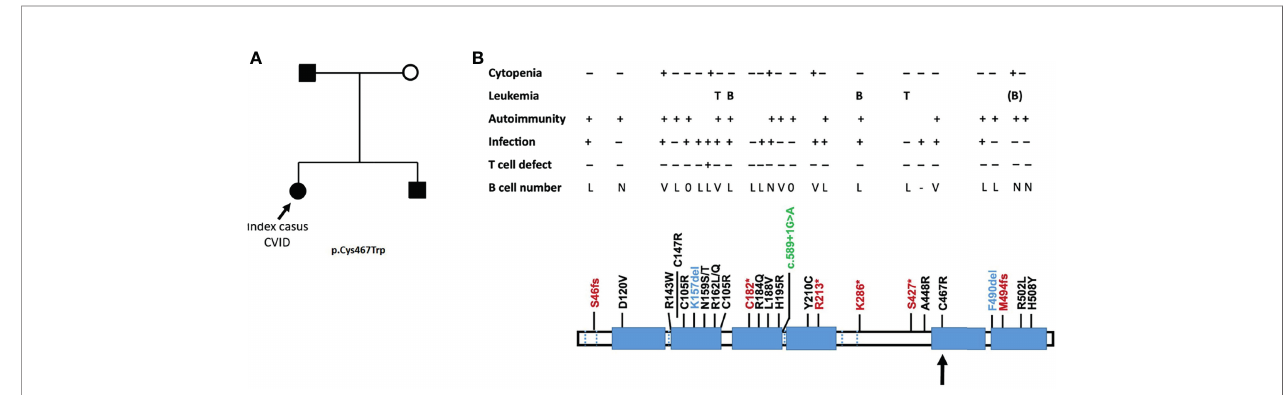
FIGURE 1 | (A) Family tree with the genetically affected members following haploinsuf fi ciency with variable penetrance. The index case is indicated by an arrow, who presented with a typical CVID. (B) The position of the mutation is with an arrow (adapted from Yamashita et al. (7). Mutations comprise early stop codons (red), missense mutations (black), a deletion (blue), and splice defect (green). Larger deletions causing a complete haploinsuf fi ciency have also been described (7). L, low; V, variable; N,